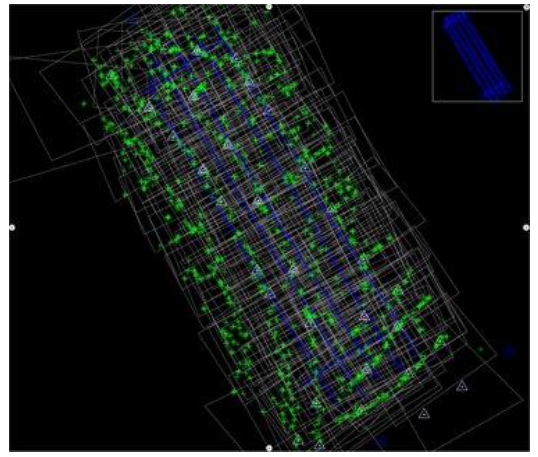
Figure 6: Ricoh/Zeiss image block with automatic tie points from MATCH-AT (flight August, 23 rd , 2012).